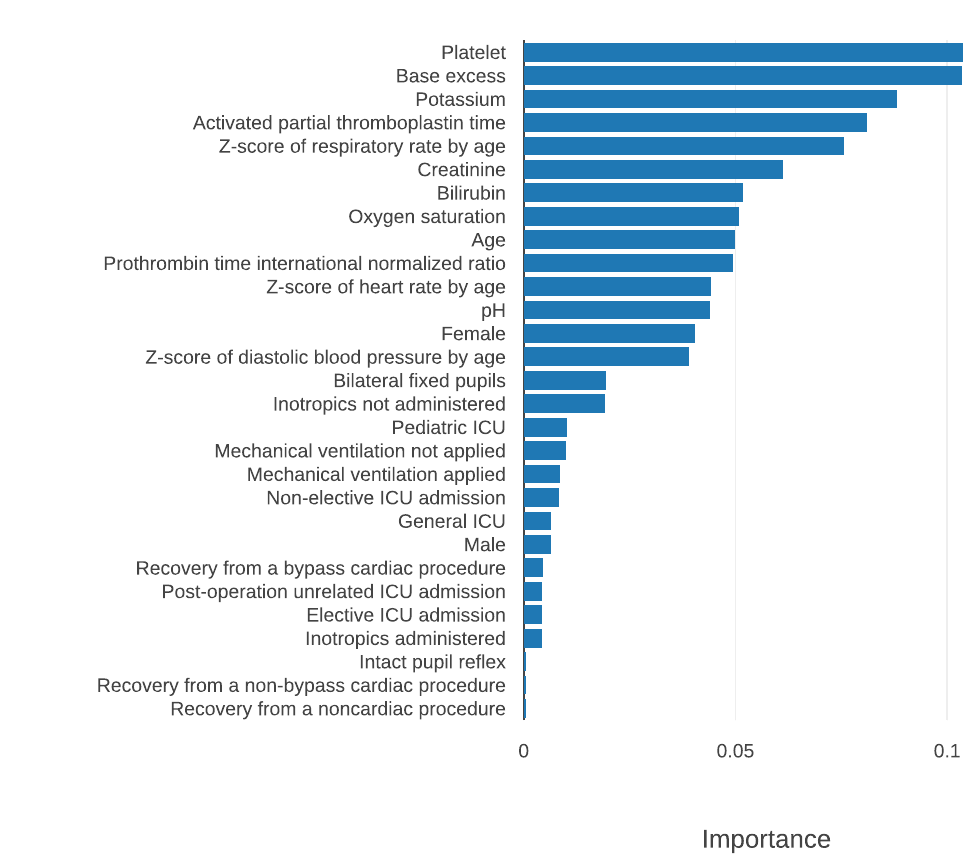
Figure 3. Relative importance of the random forest model variables. The importance of each feature was calculated through information gain using the difference in GINI impurity reduction. The “feature importance” function of Python’s scikit-learn library was used. ICU = intensive care